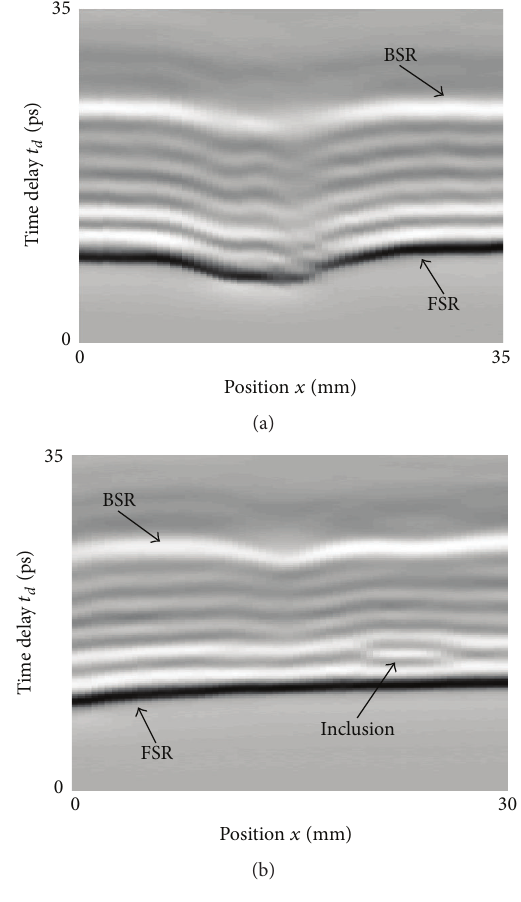
Figure 4: Selected B-scan results of pulsed terahertz inspection: (a) 5J impact caused defect and (b) thin inclusion under 1th